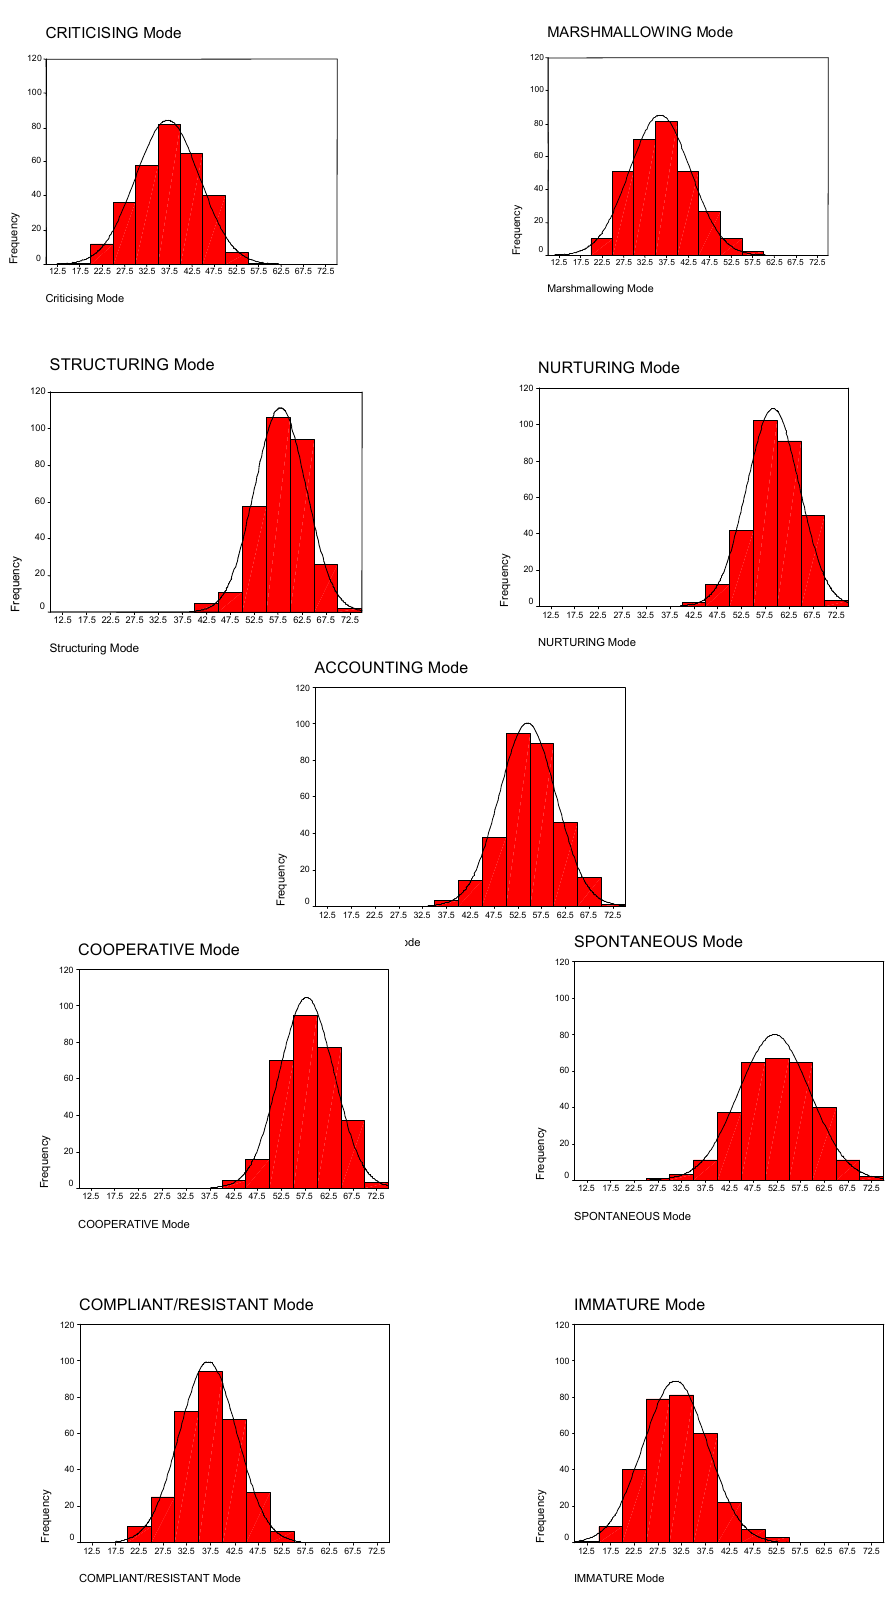
Figure 3: Total Pilot Mode Frequencies, Showing Distribution Round the